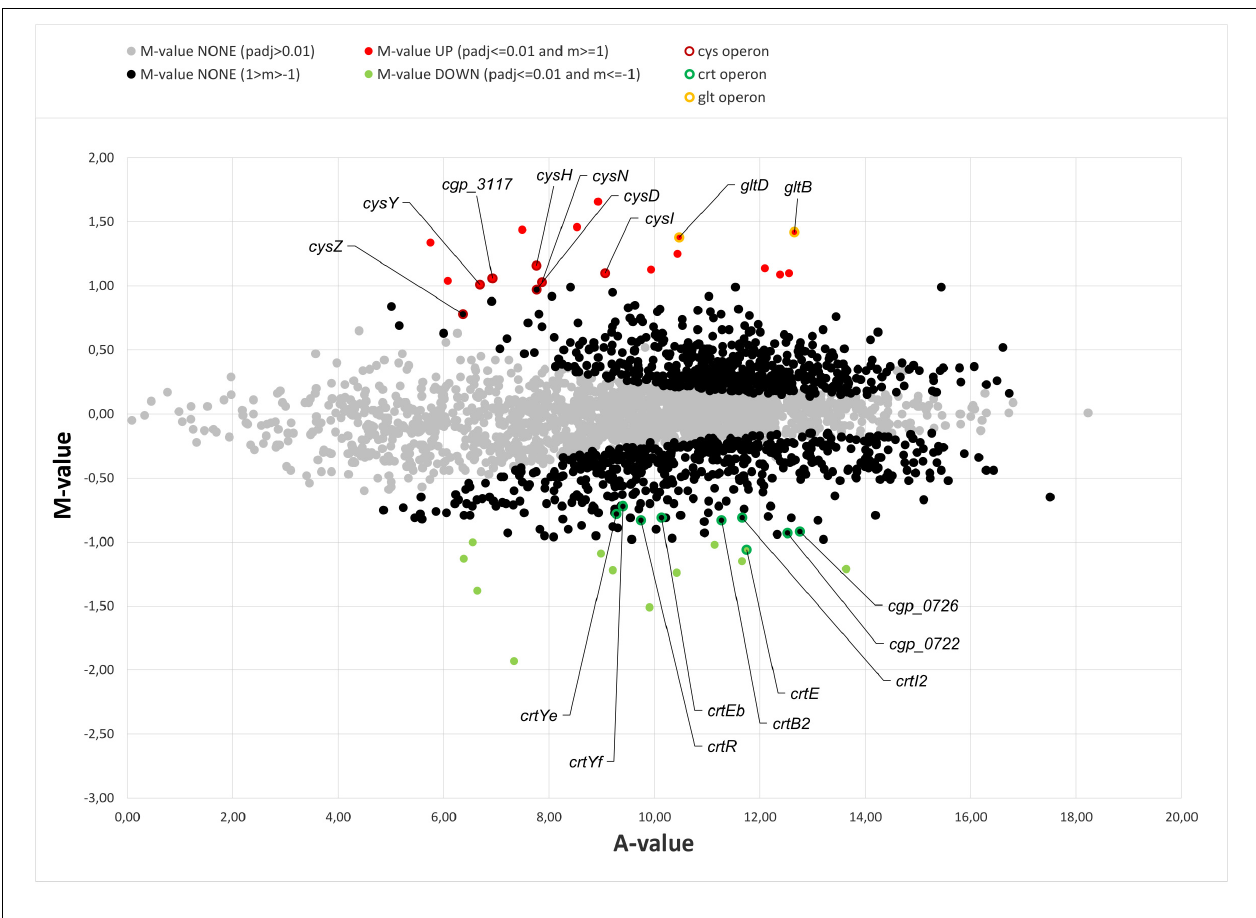
FIGURE 4 | MA-plot of transcriptome data from early exponential growth phase: C. glutamicum CR099 (cid:49) rel (cid:49) relS (cid:49) relH vs. C. glutamicum CR099. Visualization of transcriptomic data from three biological replicates each, transformed onto M (log 2 fold change) and A (mean average) values, using DESeq2 (Love et al., 2014). Significantly differentially transcribed genes are labeled in red ( M : > 1; p adj : < 0.01) and green ( M : < − 1; p adj : < 0.01), respectively. Genes below the fold change threshold with a significant probability value (1 > M > 1; p adj : < 0.01) are visualized in black and genes with a p adj : > 0.01 in gray. Representatives of the cys , crt , and glt operons are highlighted by colored borders: cys : dark red; crt : dark green; glt :